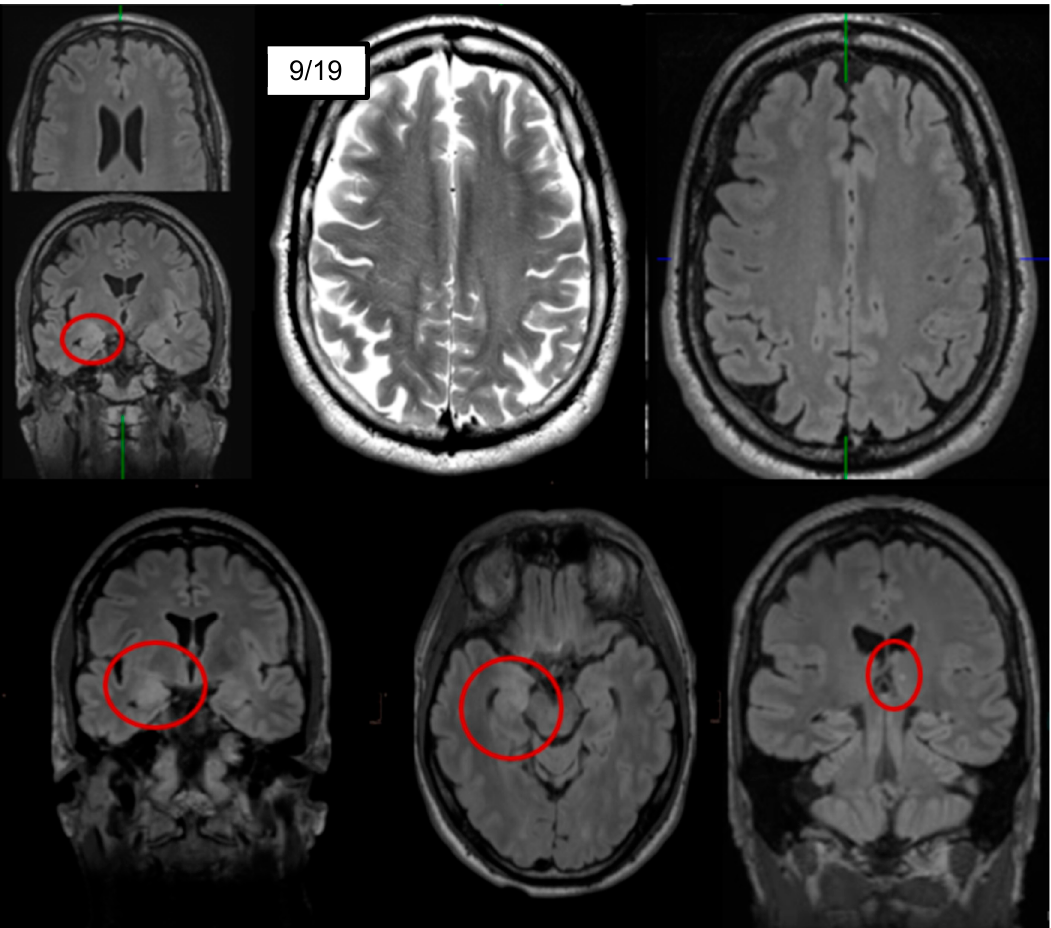
Figure 2. Magnetic resonance imaging showing fluid-attenuated inversion recovery (FLAIR) hyperintensities right-mesio-temporally and on the right side of the corpus amygdaloideum, as well as a small, possibly microangiopathic, lesion in the left thalamus (bottom row). In addition, a slight grey–white matter blurring was observed (top center and right; cf. [8]).